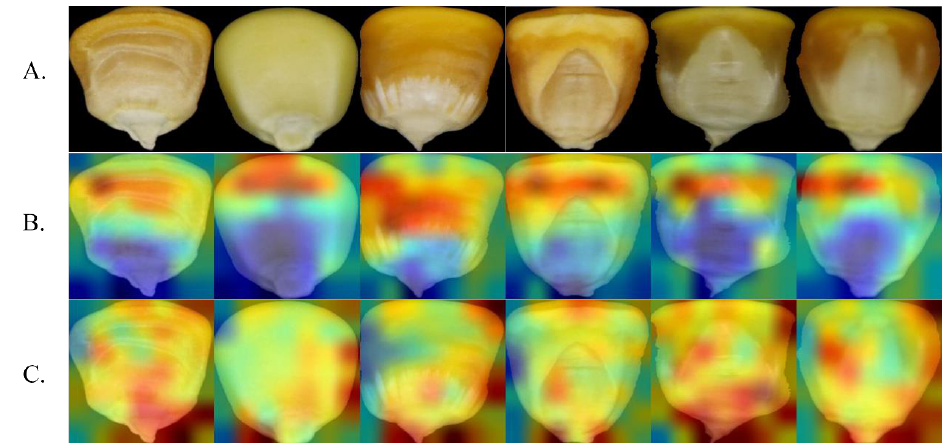
Figure 12. Comparison of MobileNetV2 and I_CBAM_MobileNetV2 attentional thermograms. ( A ) Original image. ( B ) MobileNetV2 heatmap. ( C ) I_CBAM_MobileNetV2 heatmap.